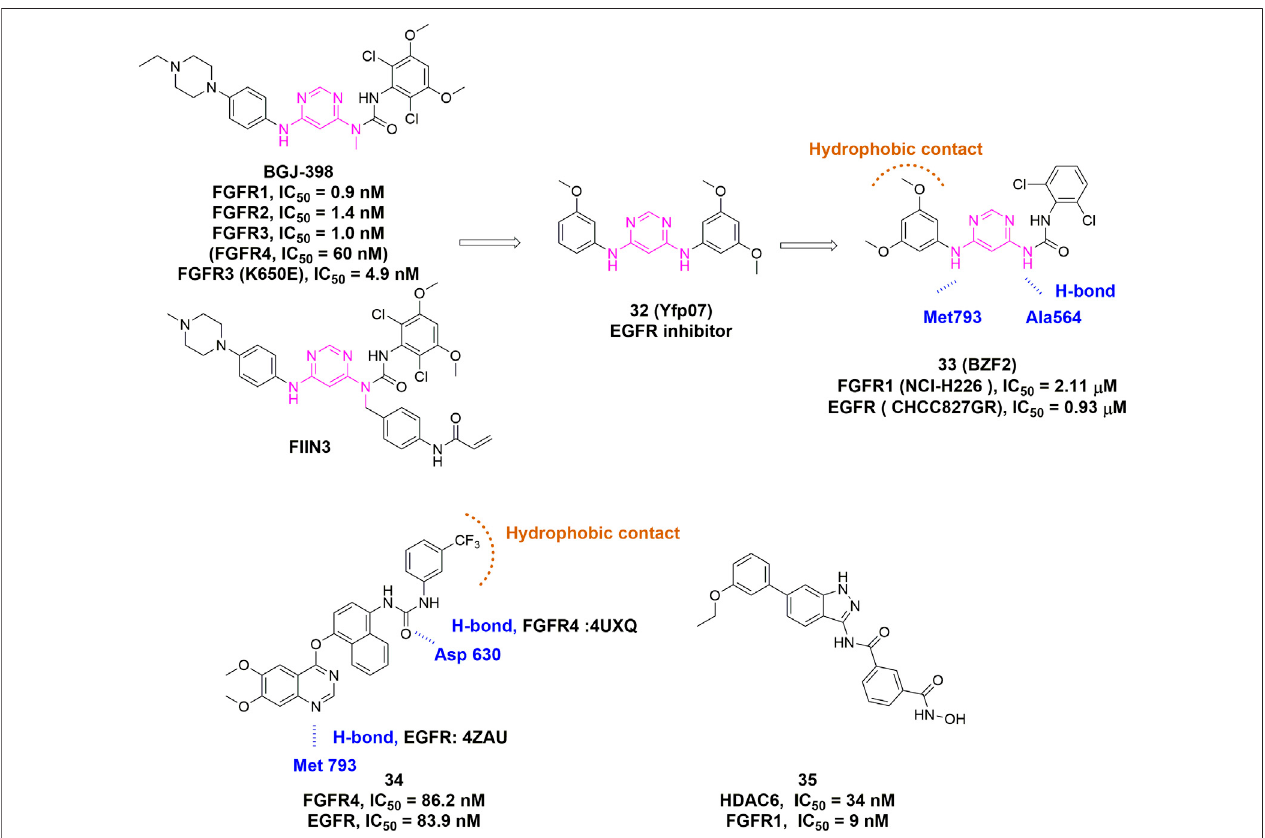
FIGURE 14 | Discovery of representative dual/multi-target inhibitors. H-bonds are outlined as blue hashed lines. Hydrophobic region is indicated by brown arc.